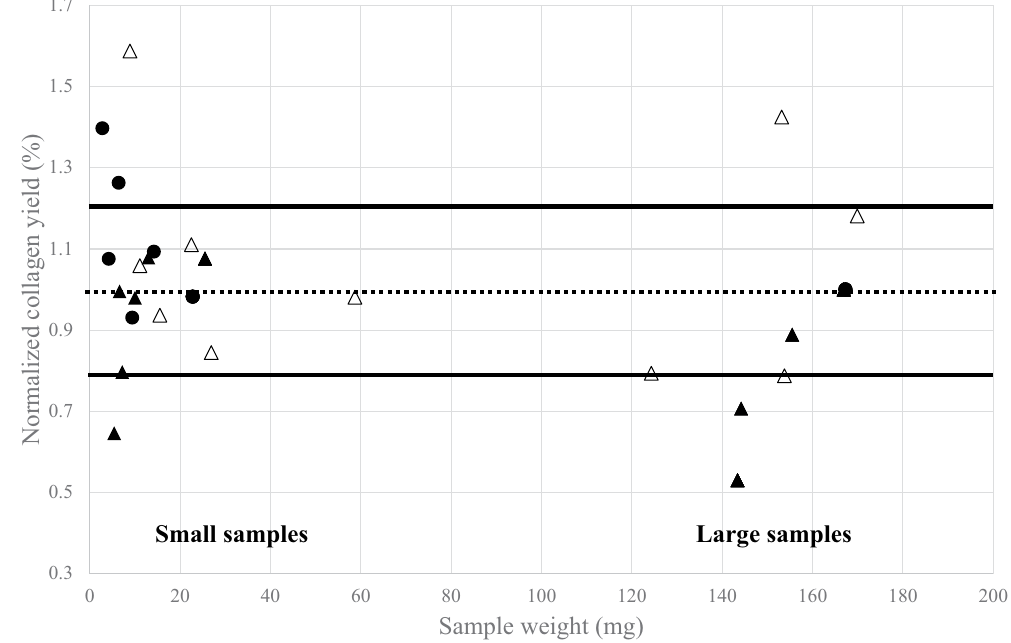
Figure 1. Relationship between sample size and collagen yield. Open circles: VIRI F horse bone sample, closed circles: VIRI I whale bone samples, open triangles: VIRI H bone samples and closed circles: VIRI E bone samples. The yield was normalized based on the yield obtained from large sample amounts ( > 100 mg) using protocol F. The dotted line indicates the normalized yield. The solid lines indicate the one sigma standard deviation for large samples prepared using different extraction